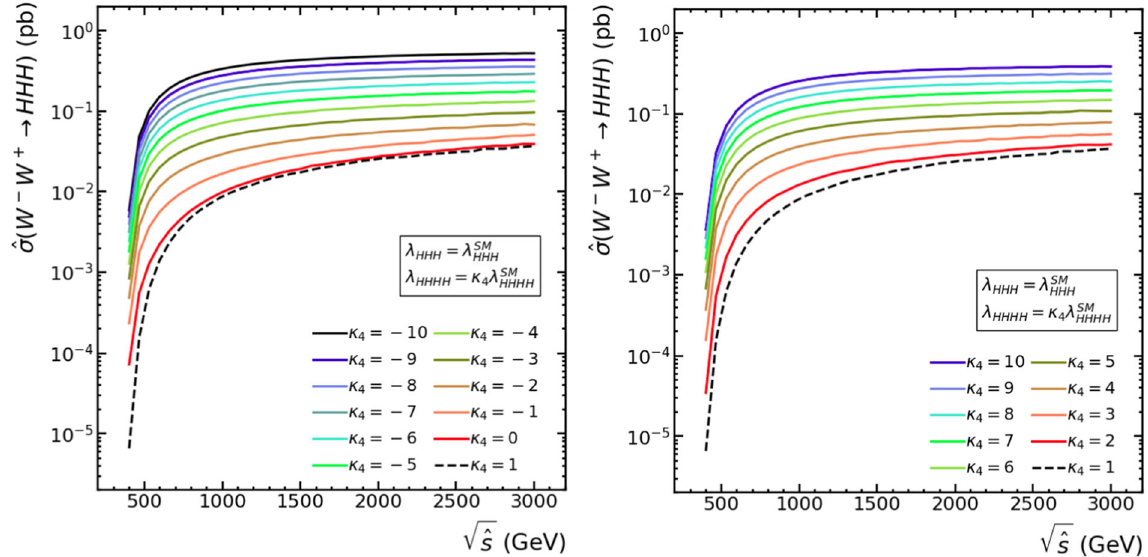
√ ˆ s for different values of the parameter κ κ 4 are shown in the left (right)